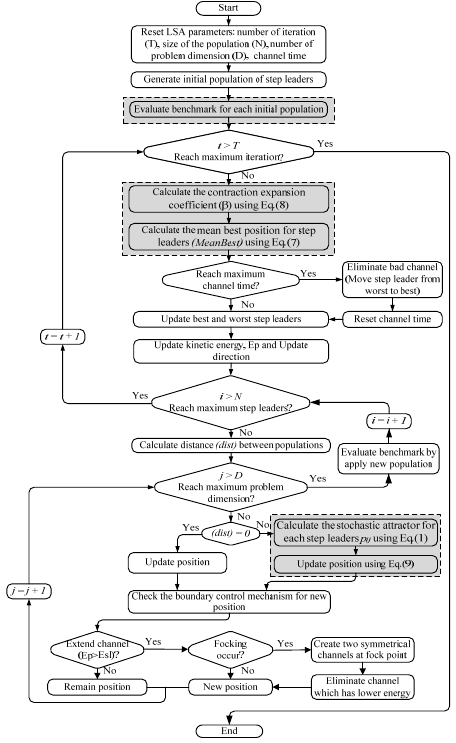
Figure 2. Flow diagram of the proposed QLSA algorithm.